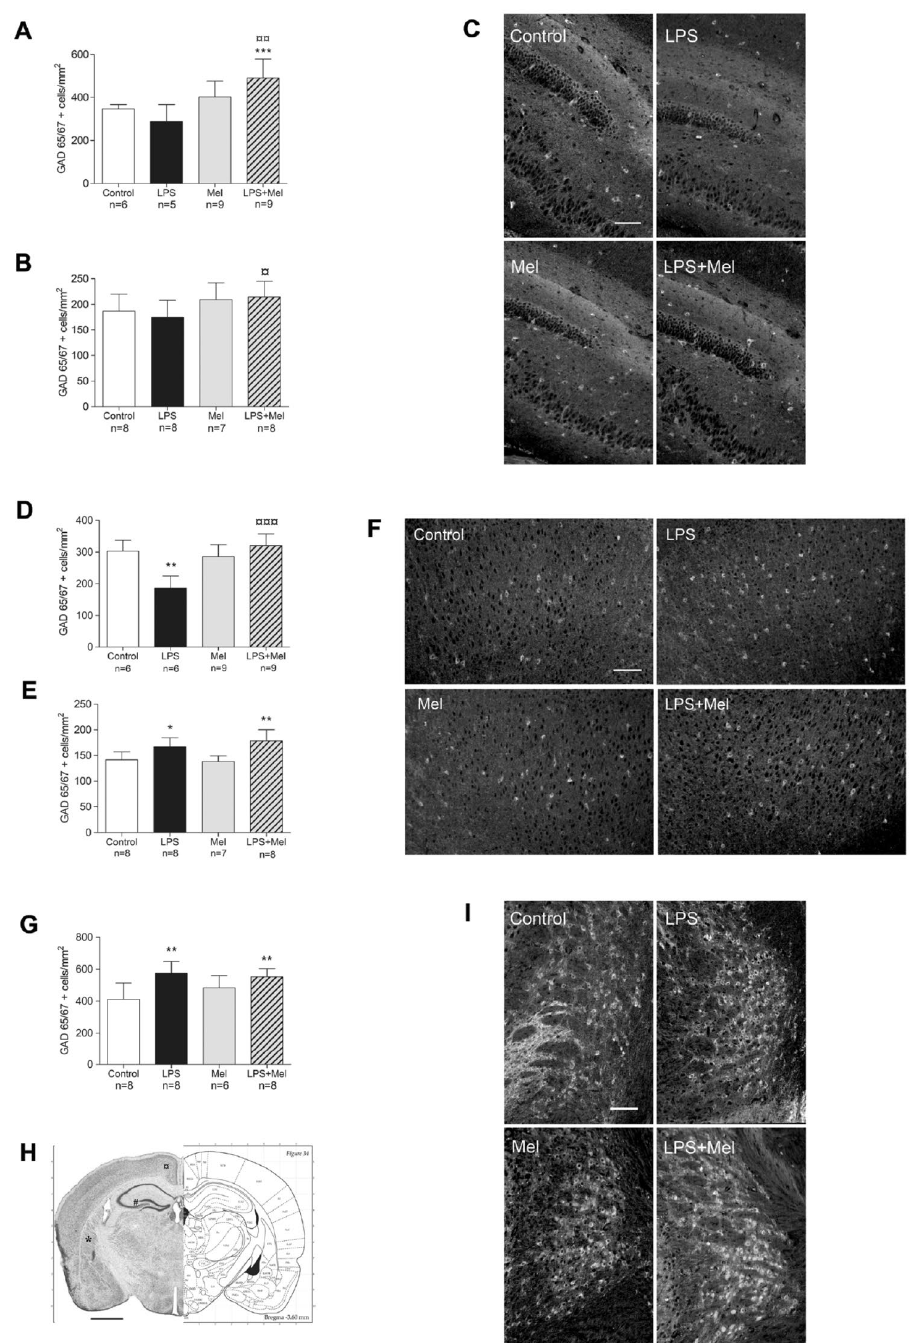
Figure 3. Melatonin demonstrated promoting effects on GABAergic neurons in the infectious/inflammatory context throughout the gray matter of the developing brain. The GAD 65/67 positive cells were counted at PND7 and at PND21 within the dentate gyrus hilus ( A,B , respectively) and the retrospenial cortex ( D,E , respectively), and are reported in the corresponding bar graphs. The GAD 65/67 positive cells were also counted at PND21 within the caudate-putamen area ( G ). Photomicrographs in grey scale of the GAD 65/67 immunostaining were performed on the PND21 pup brains from all experimental groups within the dentate gyrus ( C ), the retrospenial cortex ( F ) and the caudate-putamen area ( I ) (magnification 10, scale bar = 100 µm). Dentate gyrus, retrospenial cortex and caudate-putamen area were tagged with (#), ( ¤ ) and (*) on coronal rat brain sections extracted from the Paxinos Atlas, respectively ( H ) 50 . White, black, grey and hatched grey bars represented the Control, the liposaccharide portion of the E.Coli membrane (LPS), the melatonin (Mel) and the LPS + Mel groups, respectively. Results are expressed as the mean of positive cells/mm 2 ± standard deviation. Statistical analysis: One-Way-ANOVA test was performed associated with Bonferroni post-test, * p < 0.05, ** p < 0.01 and *** p < 0.001 in comparison with the Control group. ¤ p < 0.05, ¤¤ p < 0.01 and ¤¤¤ p < 0.001 in comparison with the LPS